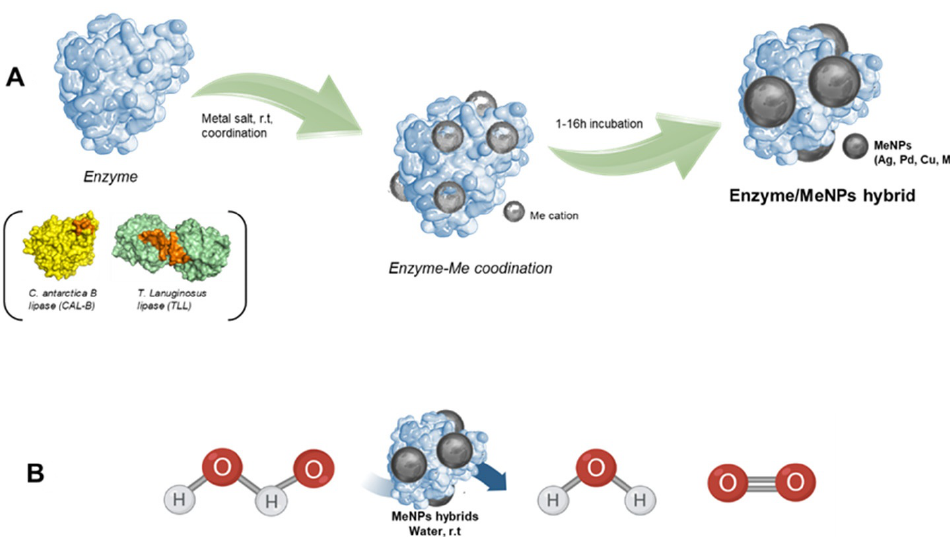
Figure 1. ( A ) Metal nanoparticle–enzyme hybrid synthesis; ( B ) catalase–like activity of different biohybrids. Me: metal, NP: nanoparticles.